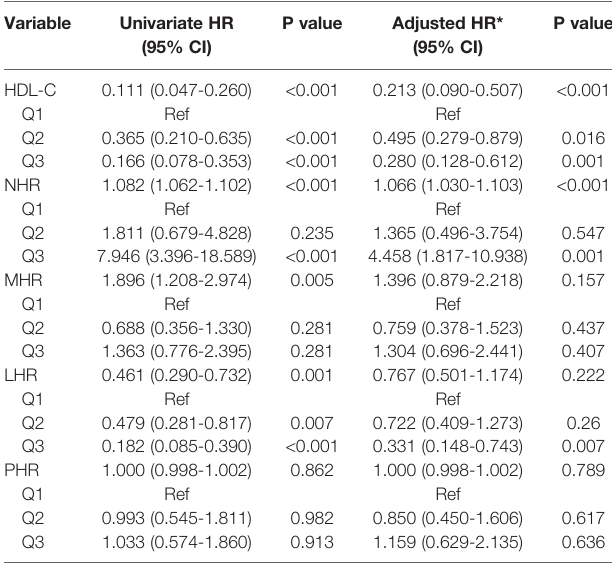
TABLE 3 | Cox proportional hazards regression model for primary composite end point among patients with COVID-19. Variable